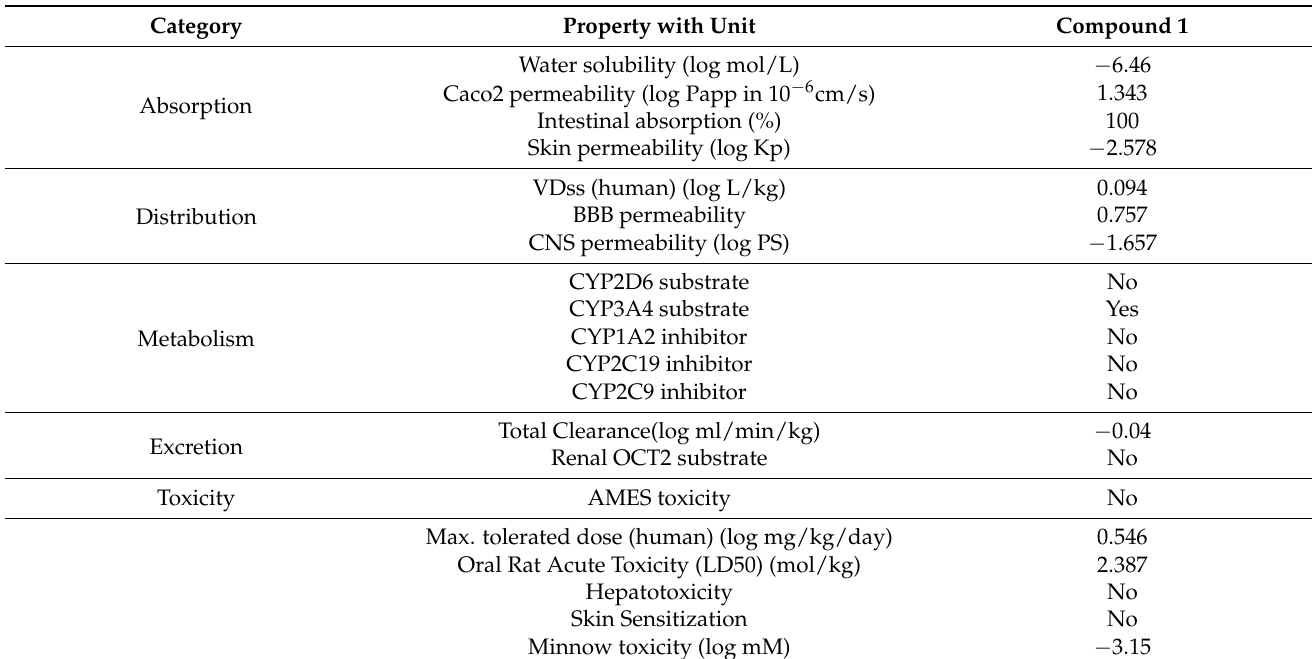
Table 6. Pharmacokinetic (ADMET) properties.